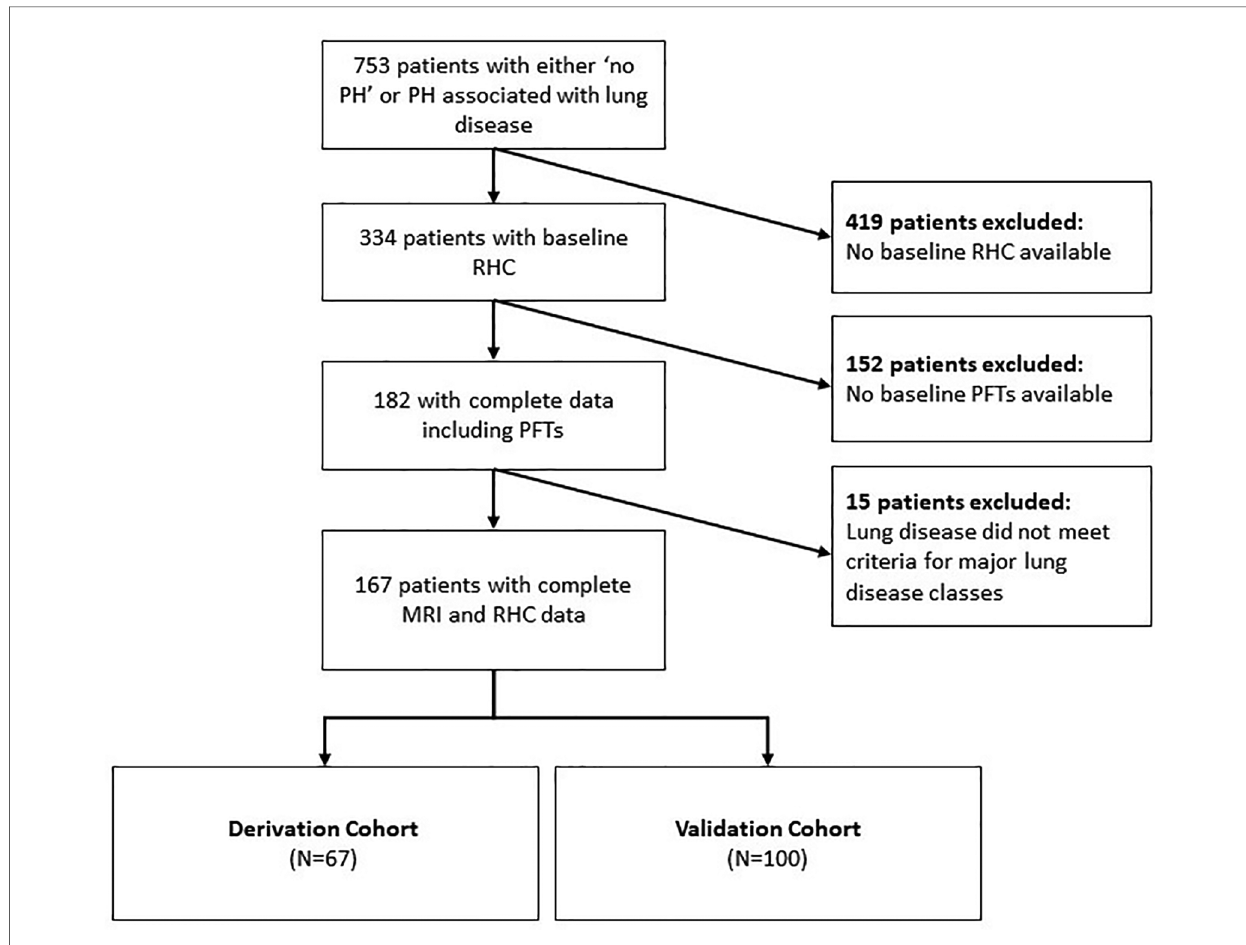
FIGURE 1 Patient selection fl ow chart. Inclusion criteria included those with complete RHC, PFT and MRI data and exclusion criteria included those with lung diseases not meeting criteria of major lung disease classes or those with coexisting disorders such as left heart disease. The classi fi cation of the derivation and test sets was according to the availability of their echocardiography data, where the derivation set of patients had no echocardiography measures. PH: pulmonary hypertension; RHC: right heart catheter; RFT: pulmonary function tests; MRI: magnetic resonance